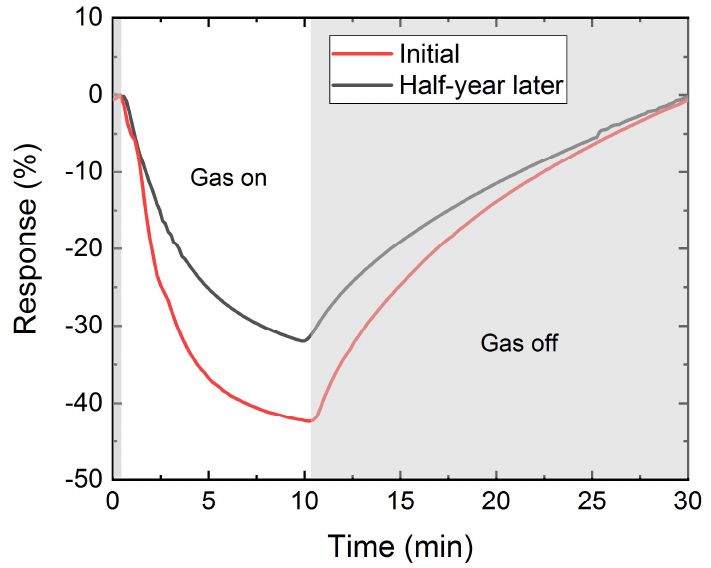
Figure 6. Real time response of the sensor obtained with NO 2 sample at the concentration of 0.8 ppm for the as-fabricated device (red) and after half a year of exposure to ambient conditions (black).